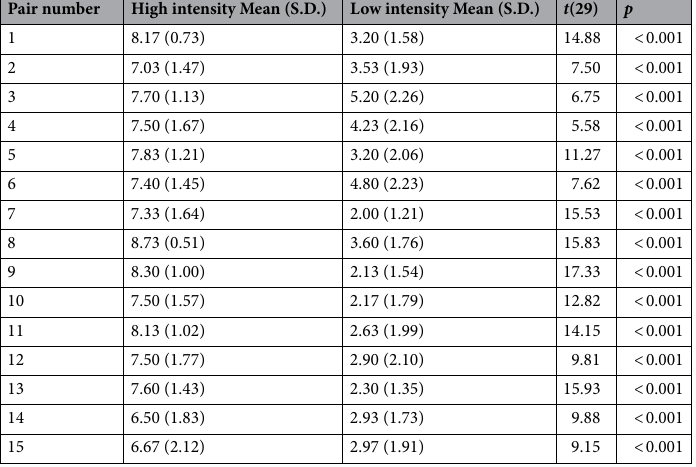
Table 1. Means, standard deviations (S.D.s) and comparison between high and low intensity sentences. Means and SDs of the negative experience ratings across participants for high and low intensity sentences of each of the 15 sentence pairs, as well as t and p values for the comparison between negative experience ratings of high intensity versus low intensity sentences for each